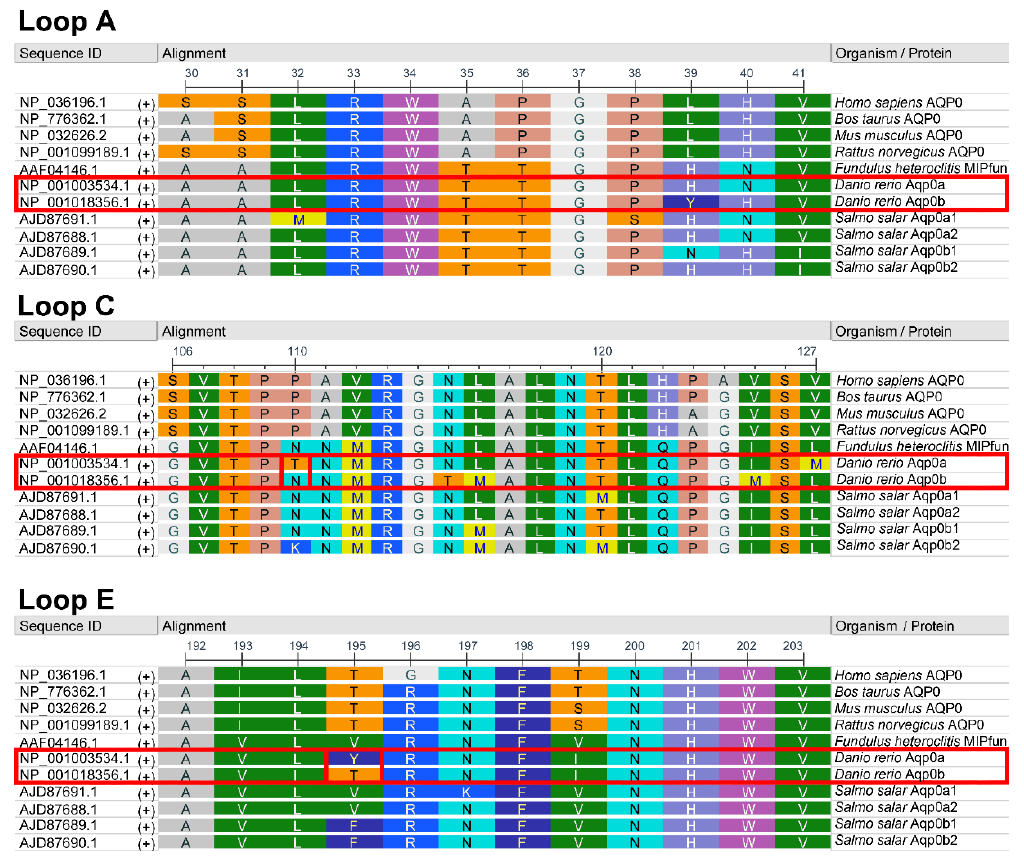
Figure 2. Zoo protein alignments of AQP0 extracellular loops. Amino acid alignment of extracellular loops A, C, and E of AQP0 across selected mammalian and piscine species. RasMol coloring. Human ( Homo sapiens ), bovine ( Bos taurus ), mouse ( Mus musculus ), and rat ( Rattus norvegicus ) AQP0 (also known as MIP) are shown. The fish Aqp0s shown include MIPfun of killifish ( Fundulus heteroclitus ) and duplicated Aqp0s for zebrafish ( Danio rerio ) and Atlantic salmon ( Salmo salar ). Two amino acids of interest indicated as boxed sites 110 and 195 were mutated in this study.